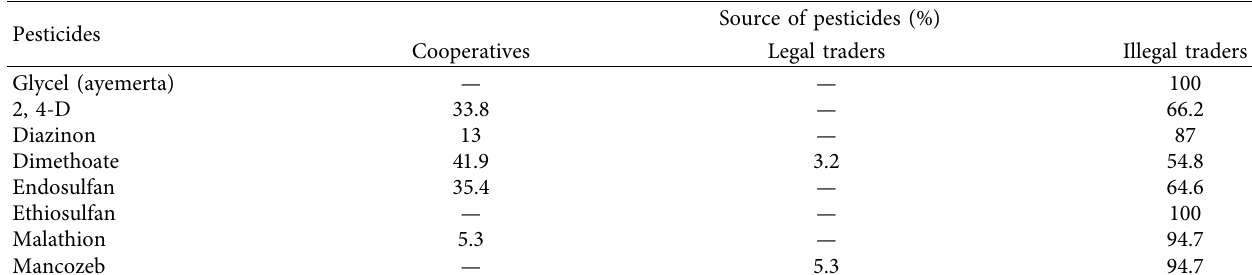
Table 8: Sources of pesticides for the